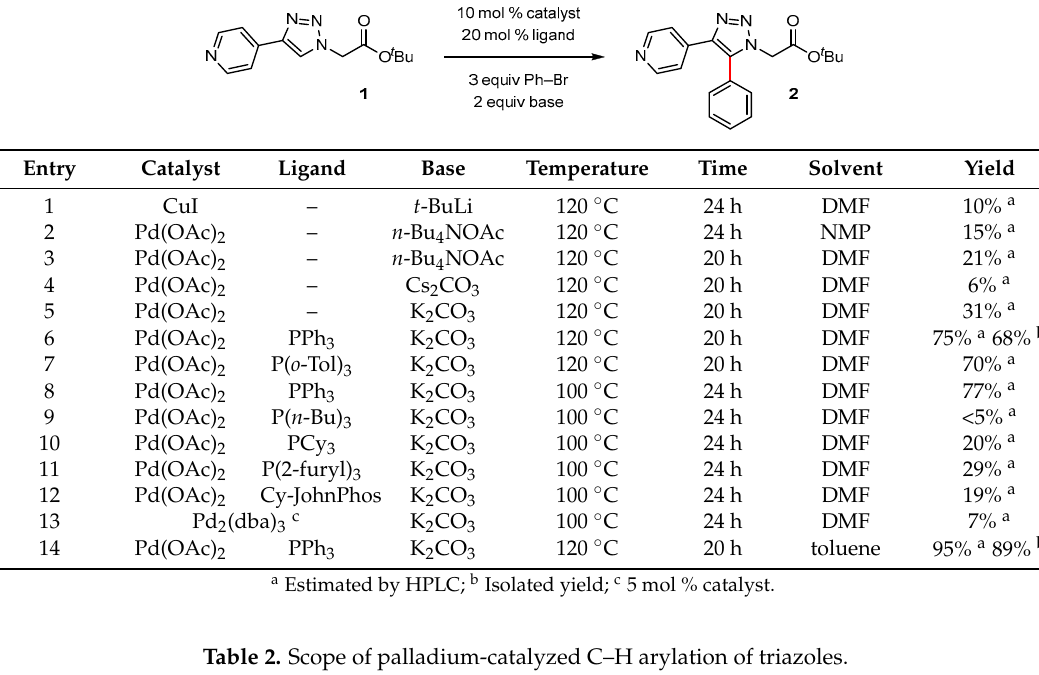
Table 1. Optimization of palladium-catalyzed C–H arylation of 1 .